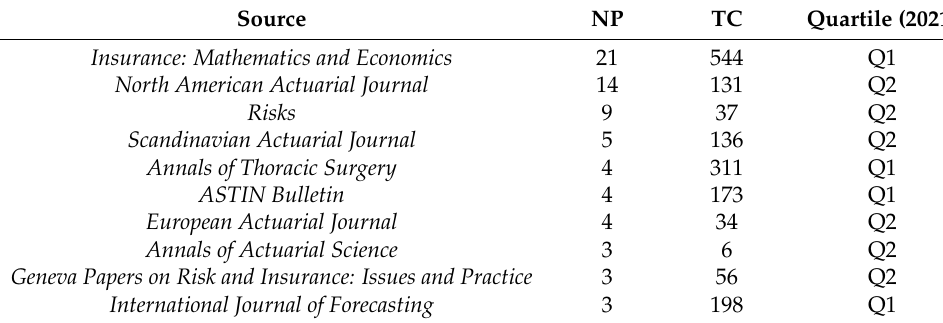
Table 3. Top 10 most active